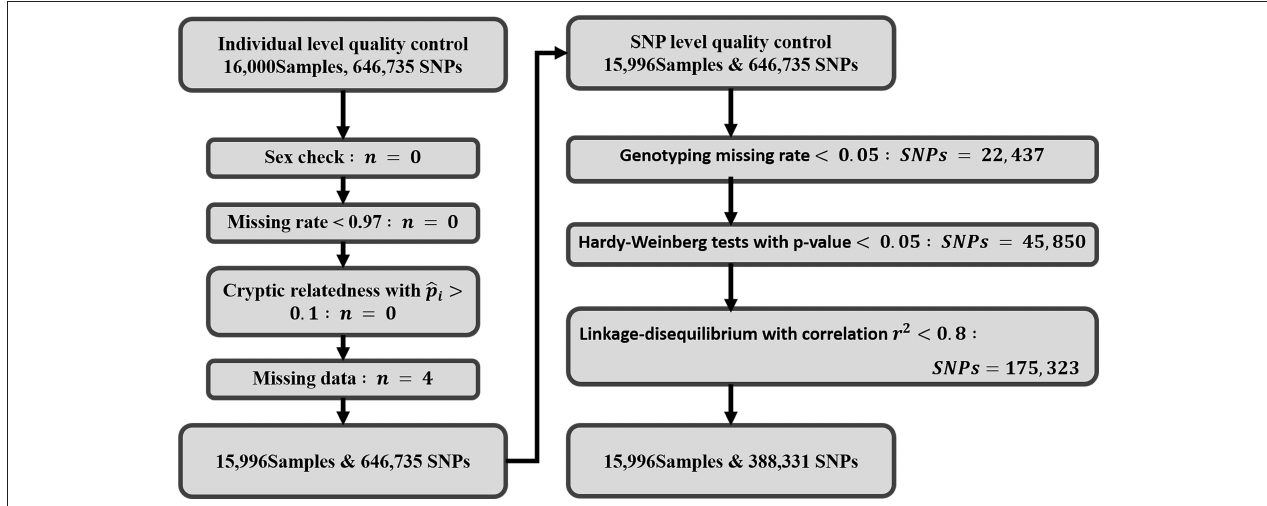
FIGURE 3 | Work flow displaying the quality control steps: exclusion criteria and inclusions of SNPs and individuals. A total of 16,000 samples and 646,735 SNPs were initially retrieved from TWB for this study. After quality control and exclusions, 15,996 Taiwanese subjects and 388,331 SNPs were retained for final analysis.